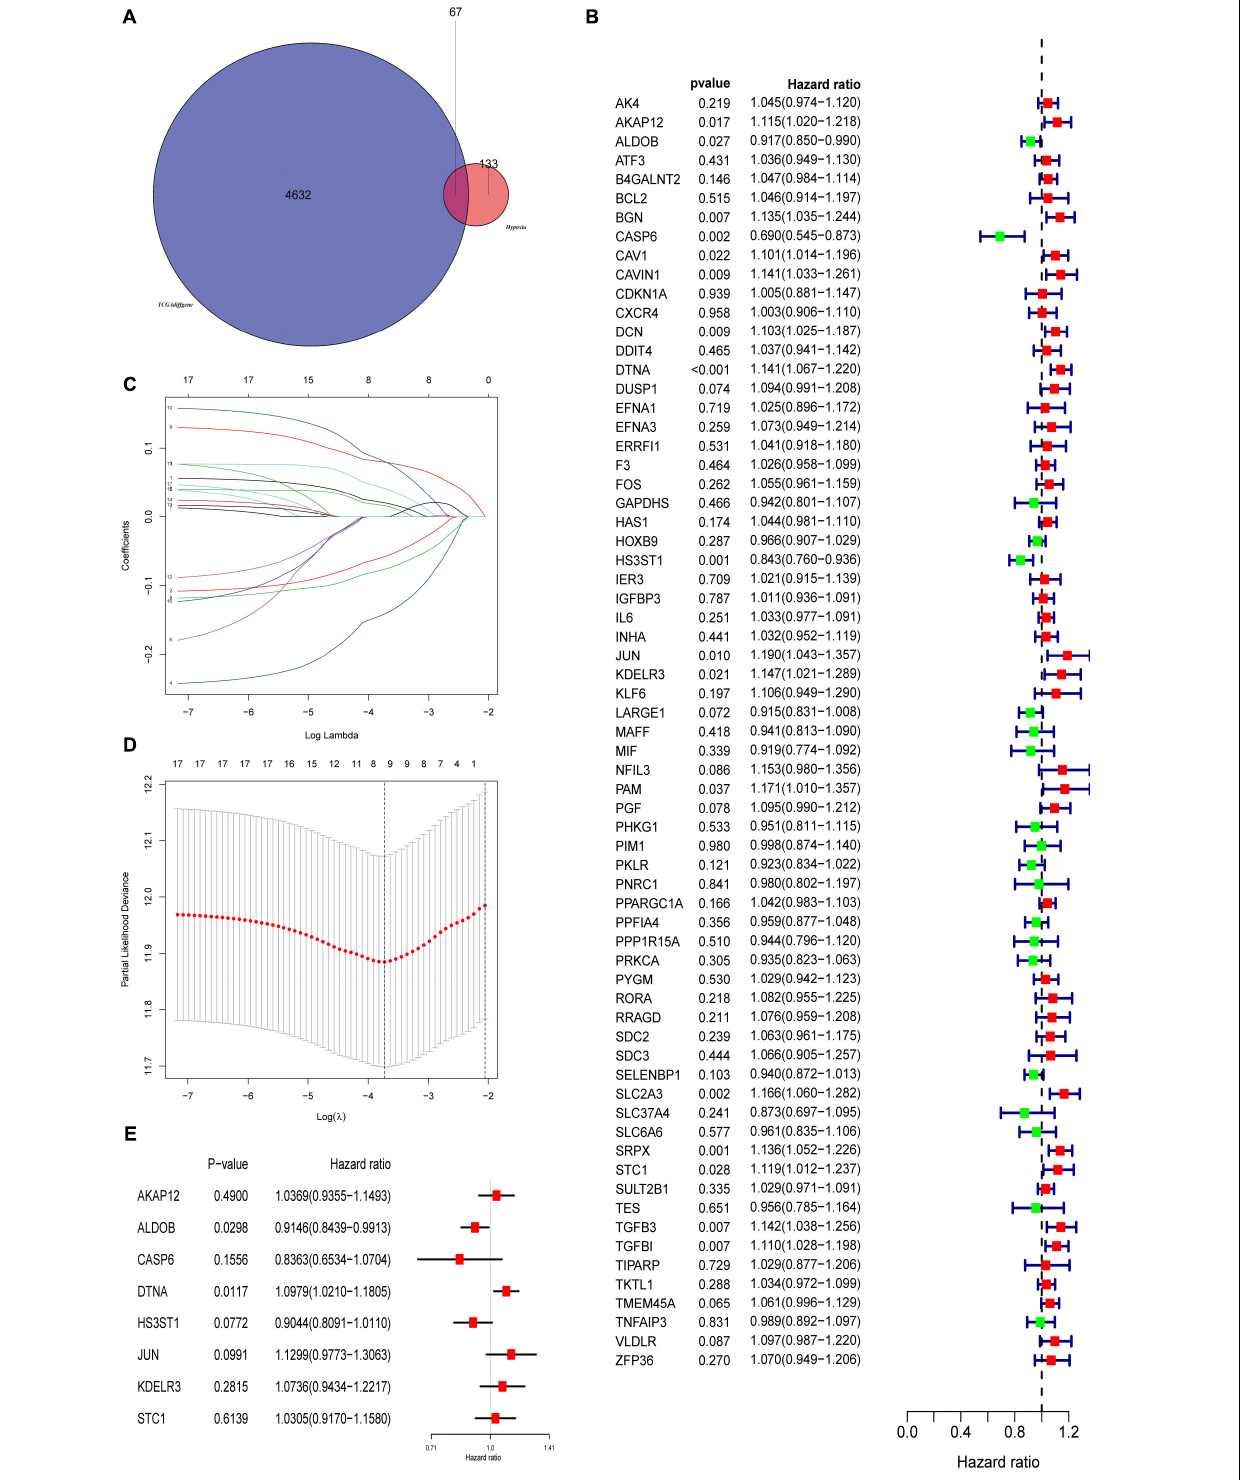
Frontiers in Genetics |